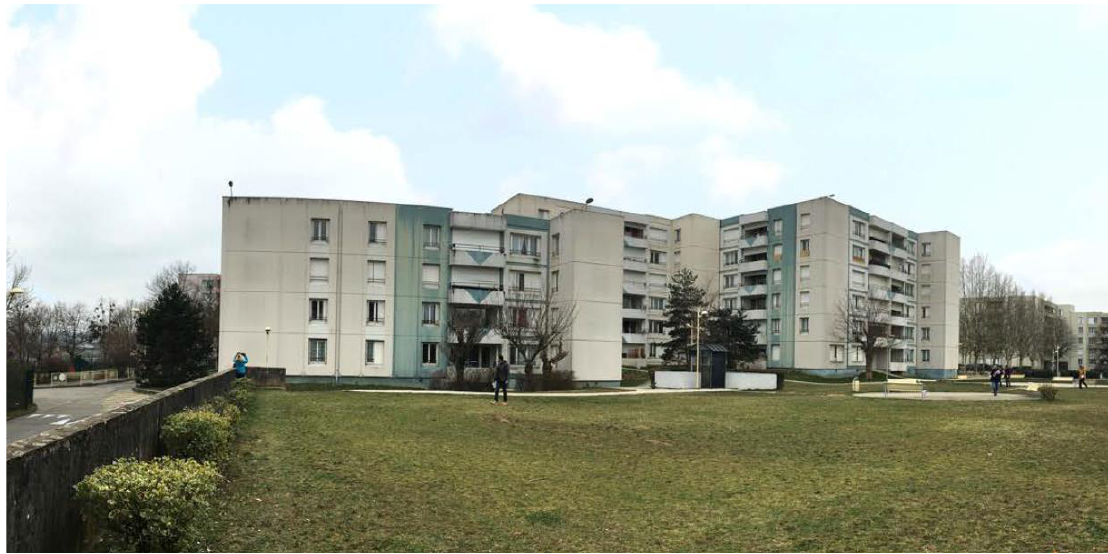
Figure 2. General view of the housing complex used to exemplify the methodology.